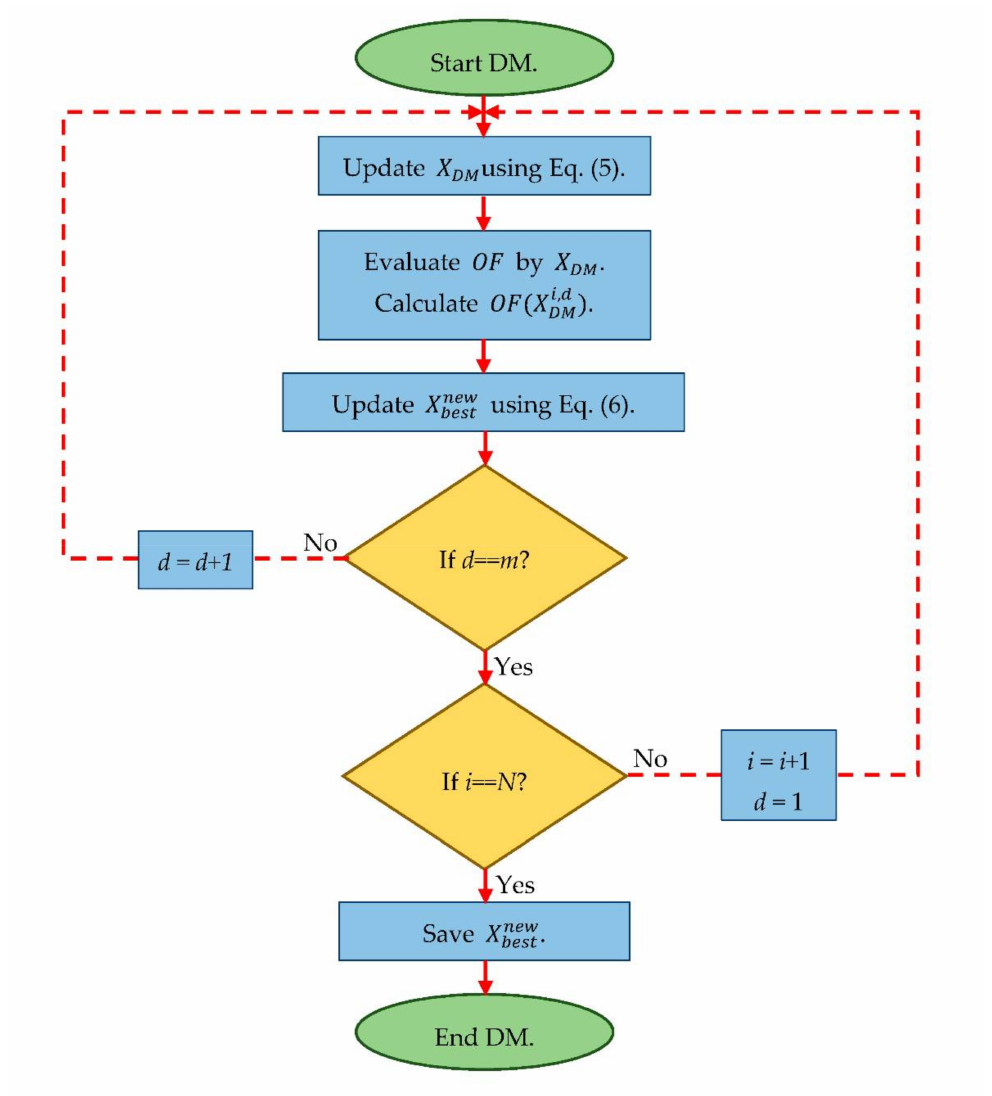
Figure 1. Flowchart of Dehghani method